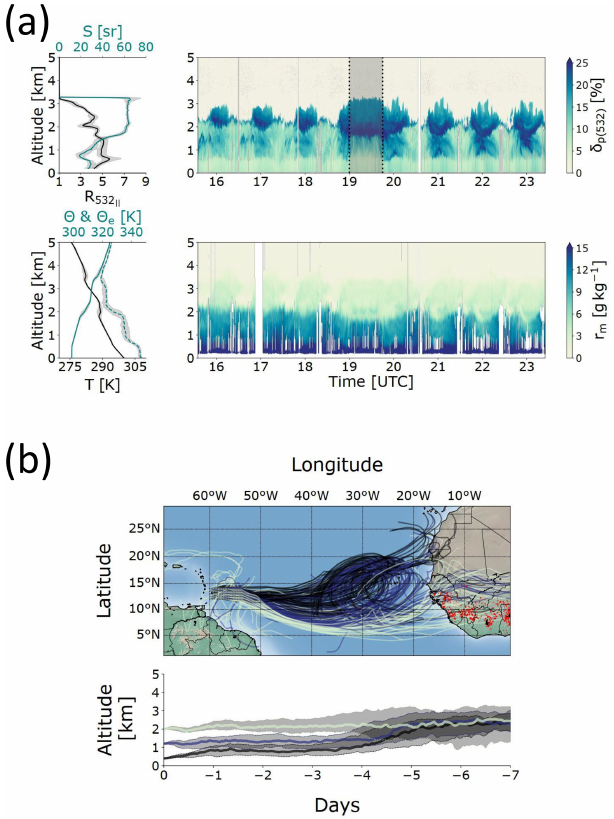
Figure 4. Same as Fig. 3 but for